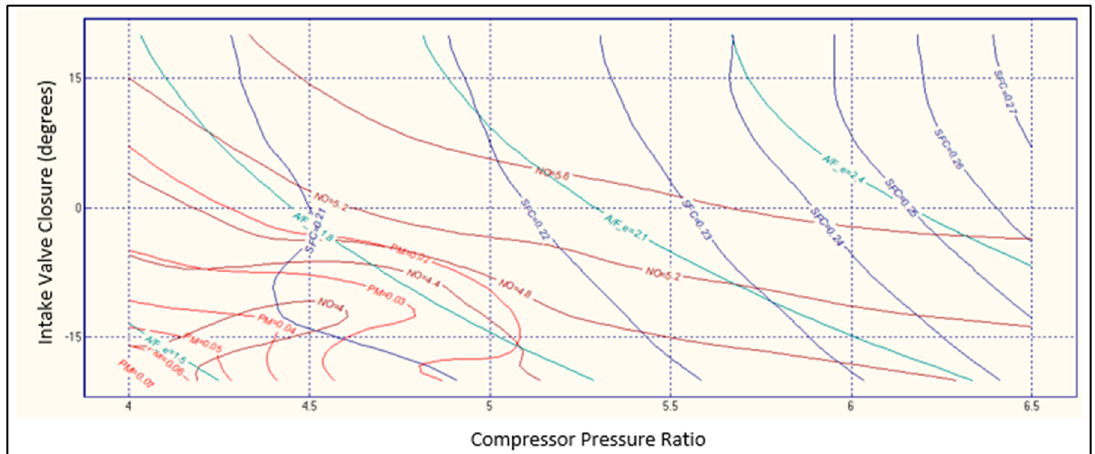
Figure 3. Two-dimensional scanning graph of intake valve closing (IVC) vs. pressure ratio of compressor (PR c ) at 1680 revolutions per minute (RPM) of the reference model (RM).